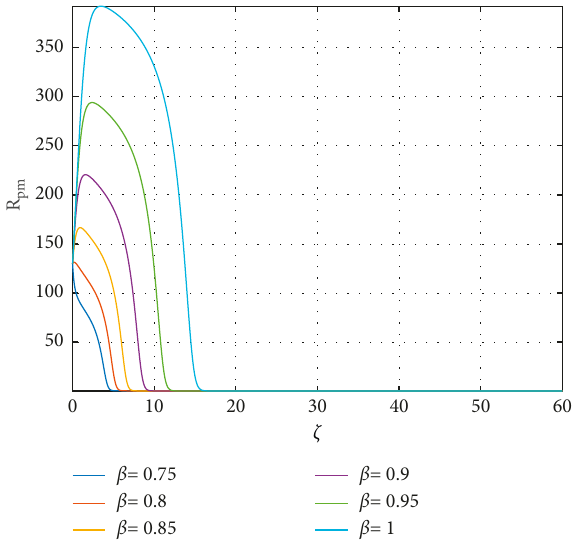
Figure 15: Two-dimensional illustration of the PM recovered R with varying contact rate q and recovery rate co-infection ρ for 2 multiple fractional orders β ∈ [ 0 , 1 ]